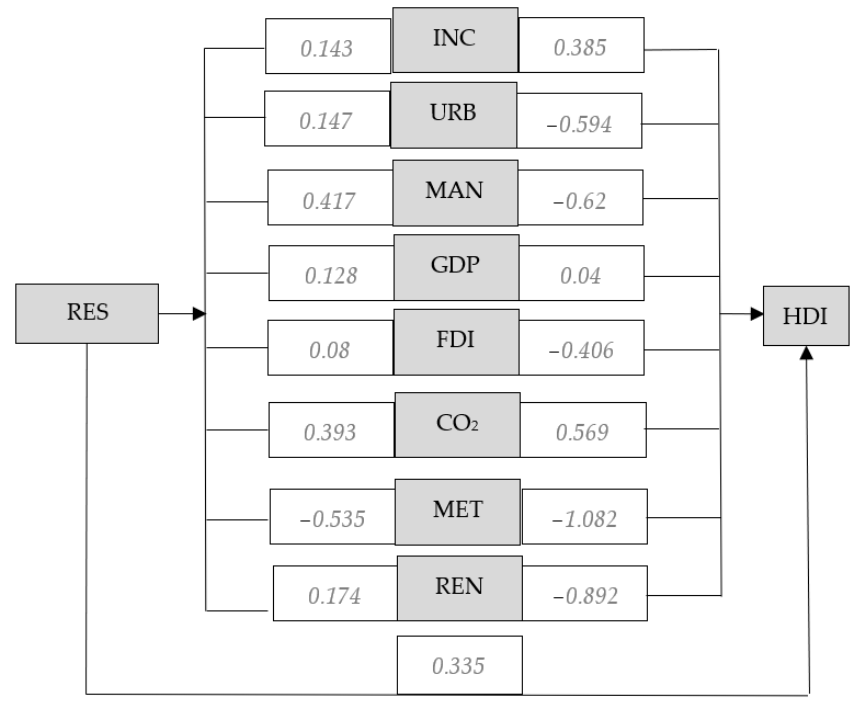
Figure A7. Role of the residential energy use per capita in explaining HDI of PCMS, 2000. Note: the insignificant values are marked with italics and grey.